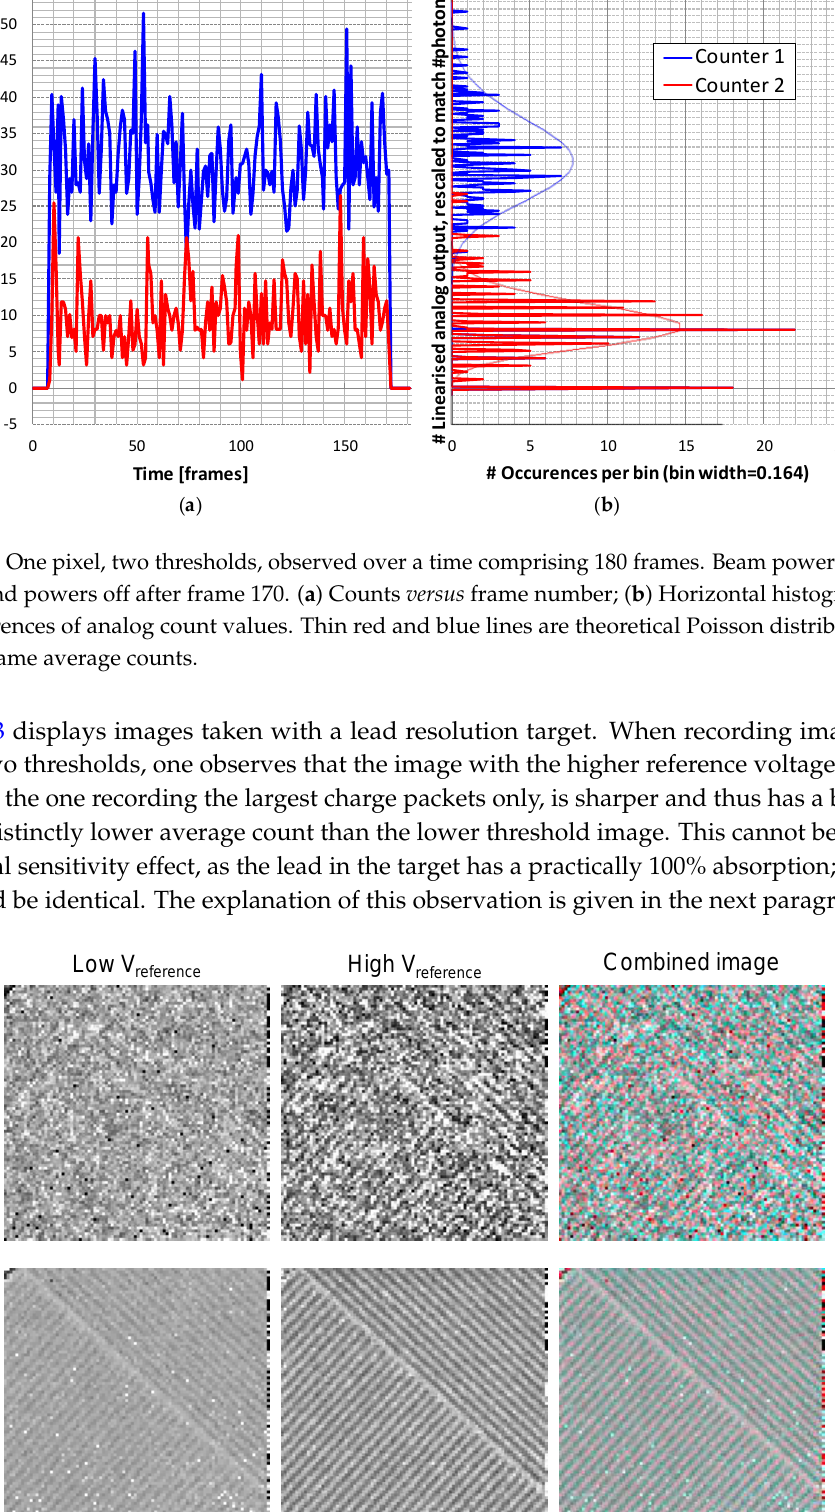
Figure 13. Images of a lead resolution target. Simultaneously recorded frames with two threshold levels (left, middle). Right: “color matrix-like” linear combination of the two frames for color rendering. Upper row: single frames; lower row: average of 55 frames.